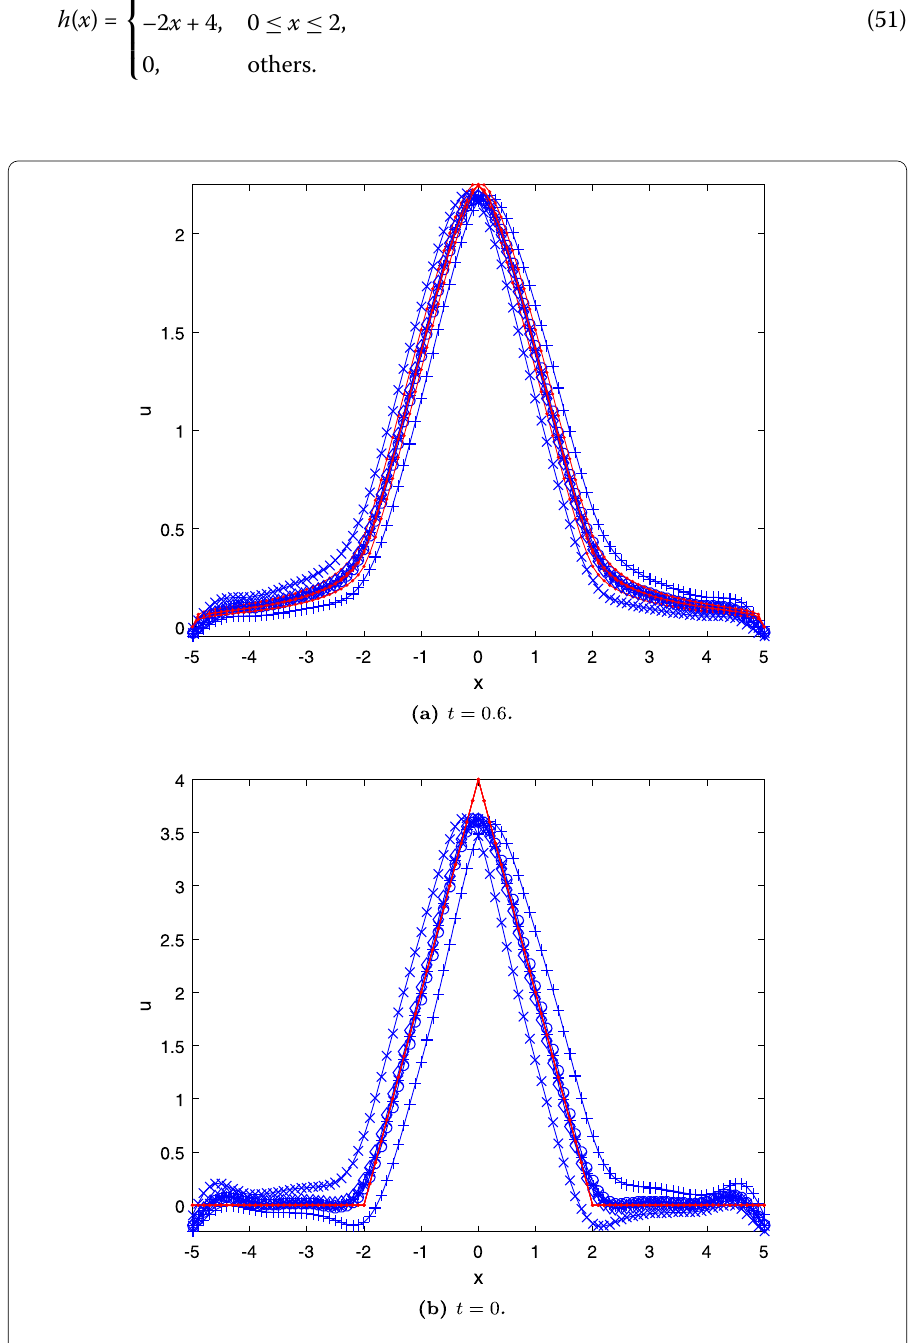
Figure 1 At t = 0.6 and 0, α = 0.5, s = 2, γ = 0.1, ε = 0.01: Exact and regularized solutions for different θ . Point: exact solution; Star line: regularized solution with θ = 0 and μ = 3.3433e–04; Loop: θ = 0.01 and μ = 3.3485e–04; Plus: θ = 0.1 and μ = 3.2330e–04; Diamond: θ = –0.01 and μ = 3.3346e–04; Multiplication: θ = –0.1 and μ =